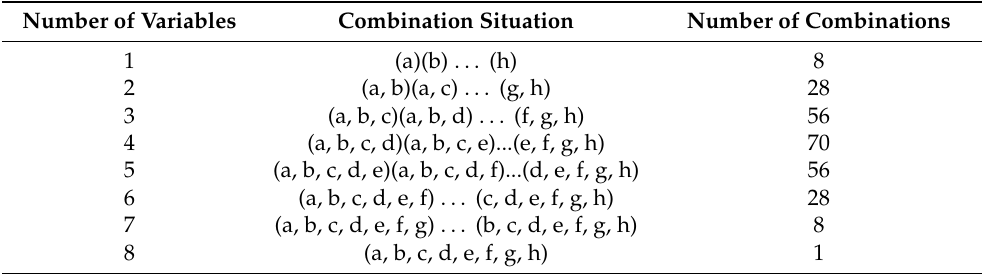
Table 2. Detailed information about variable combination generation, letters a–h present the 8 parameters listed in Table